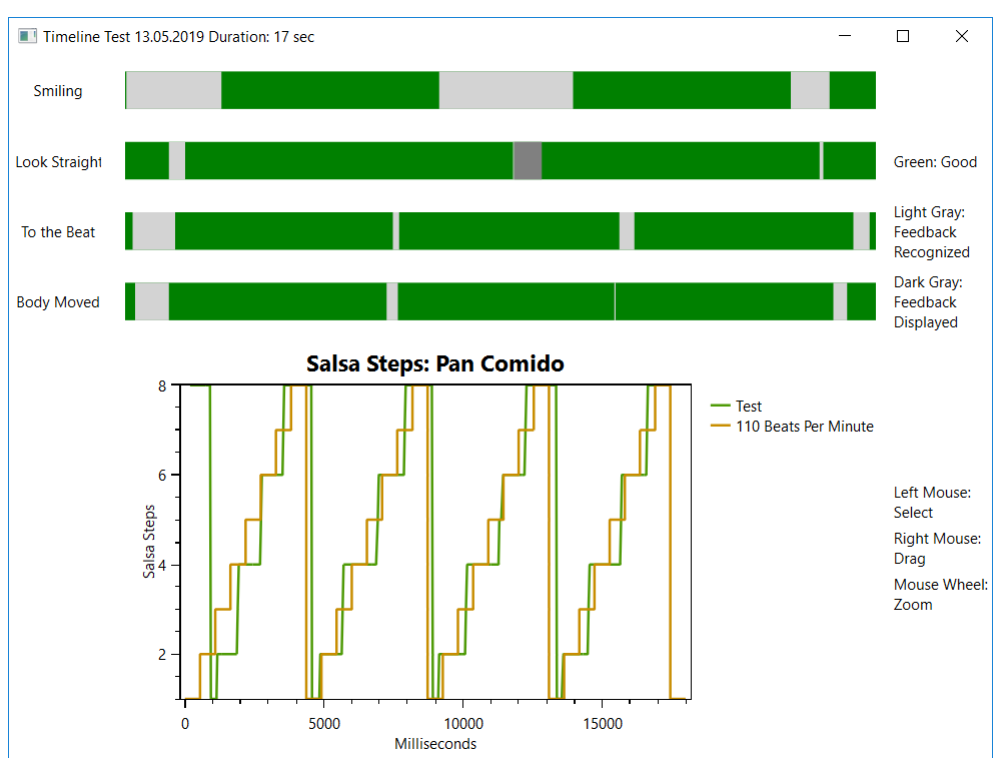
Figure 3. An example of the Offline Feedback . Top: Summary of Online Feedback that distinguishes between good ( green ), recognized ( light gray ) and displayed ( dark gray ). Down: Plot of ms and salsa steps between the suggested ( orange , 110 BPM) and the recognized steps ( green , Test).